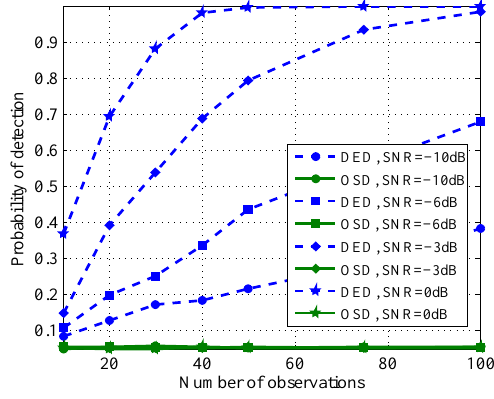
Figure 3. Probability of detection: DED and OSD vs. M for different SNRs | Gaussian primary signal | Weibull fading: Shape parameter = 1 , Scale parameter = 2 .